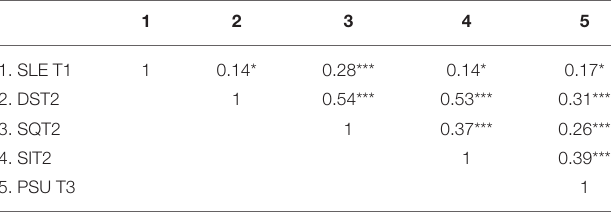
TABLE 2 | Correlations between variables at T1, T2, and